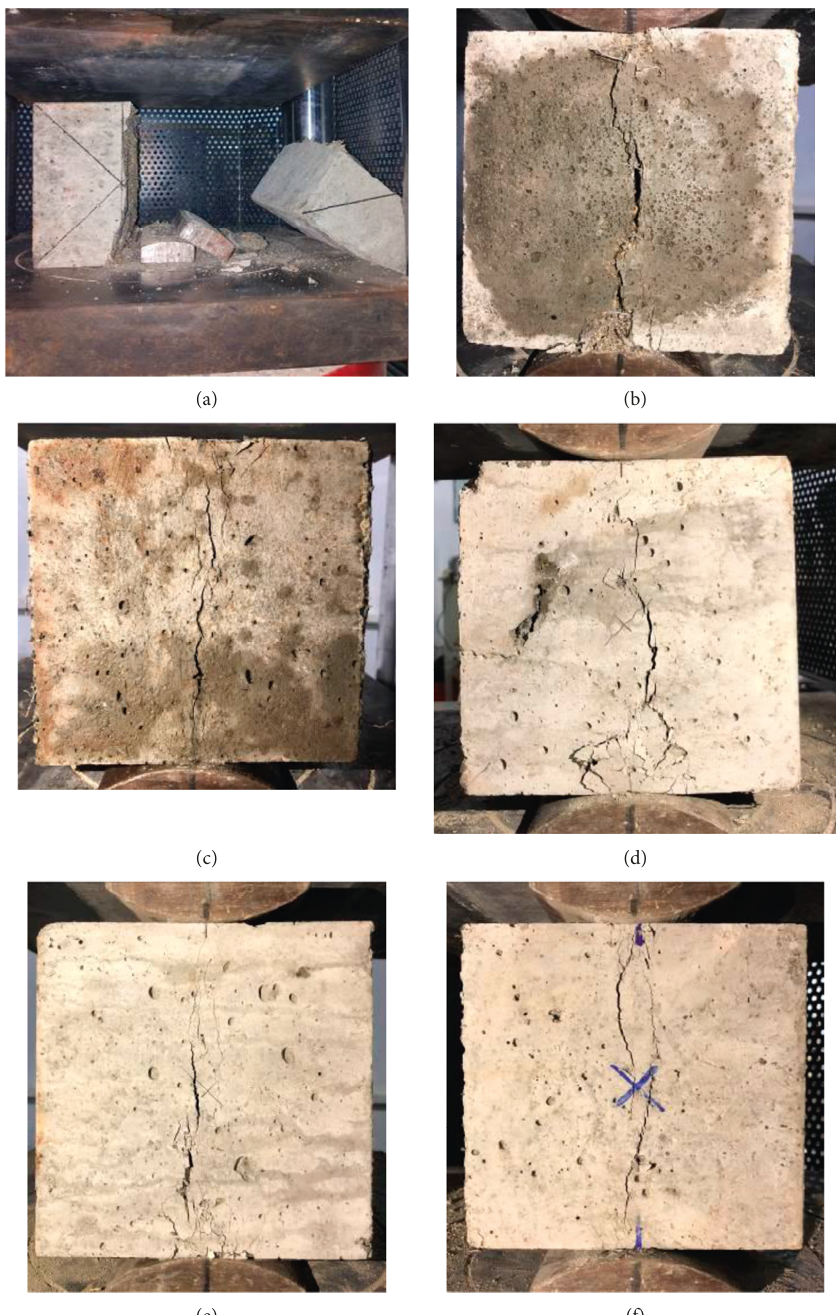
Figure 7: Typical damage shapes of concrete cubes after splitting tensile tests. (a) SF0; (b) SF0.5; (c) SF1.0; (d) SF1.5; (e) SF1NS1; (f)